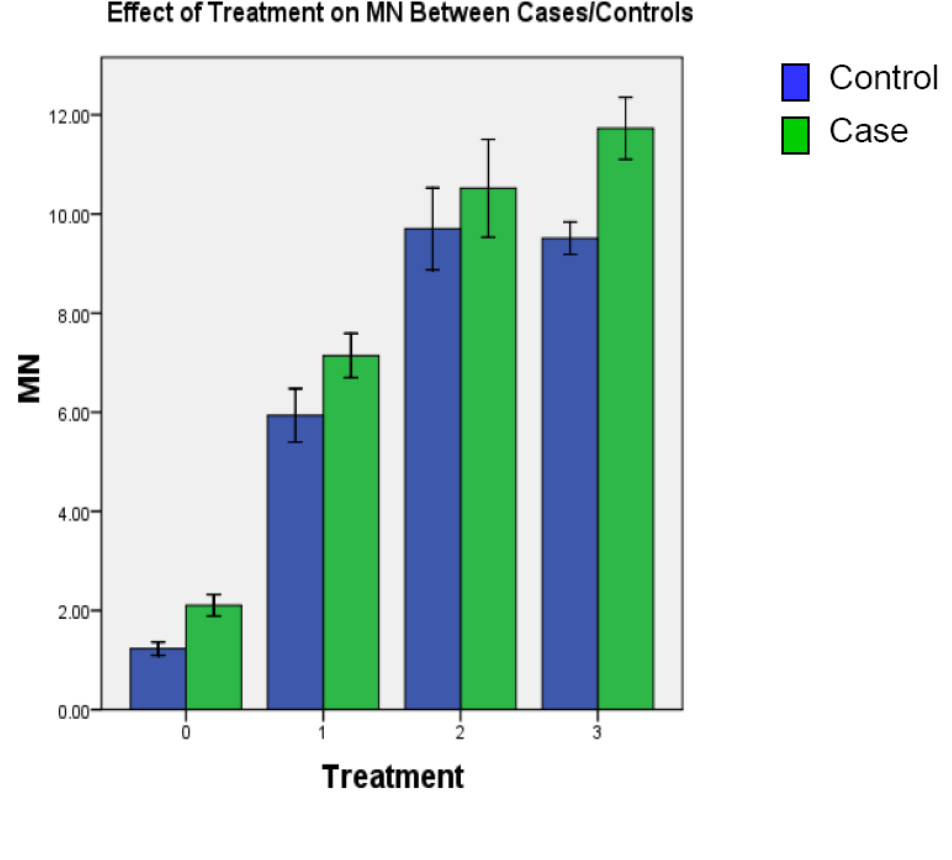
Figure 1. Relationship between induced chromosome damage (MN and NPBs) and apoptosis. The relationship between induced chromosome damage (A & B) and apoptosis (C) in cases and controls is measured and compared after each treatment of PBLs. Treatments: baseline = 0, radiation = 1, HCMV = 2 and HCMV + radiation = 3.